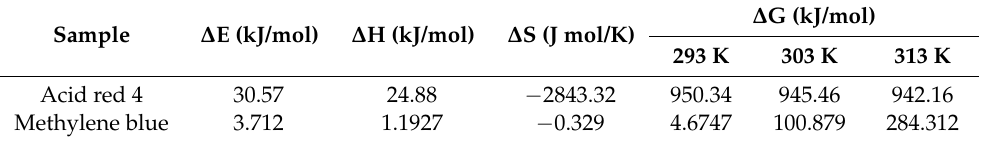
Table 6. Thermodynamic parameters for adsorption of AR4 and MB onto prepared AC.